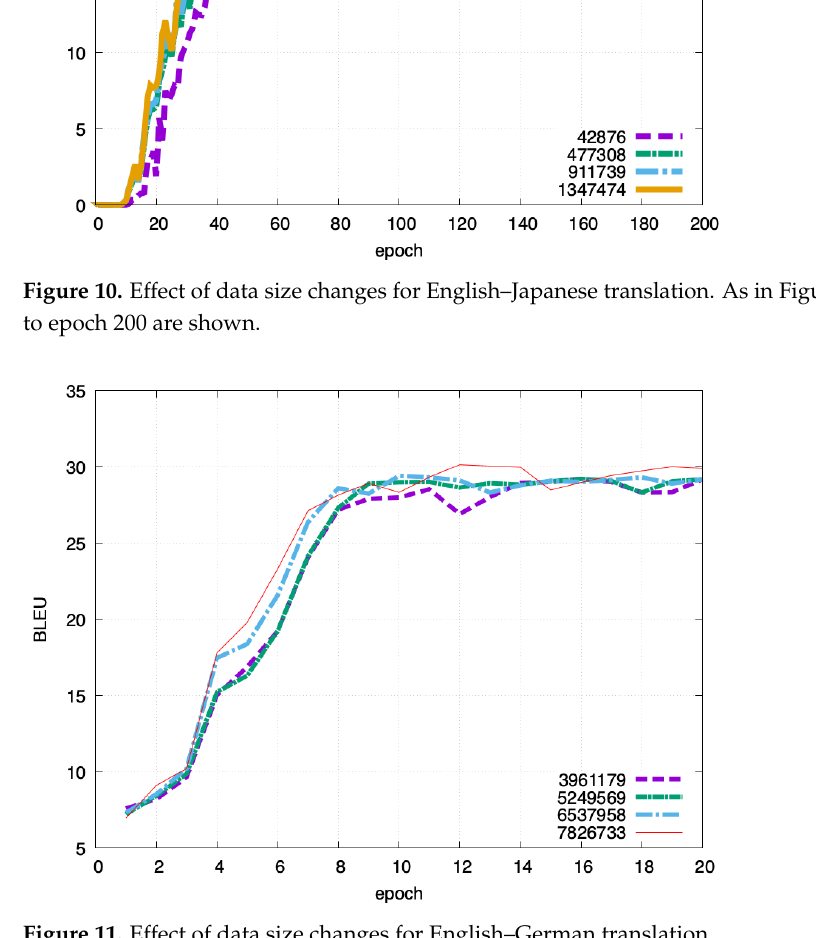
Figure 11. Effect of data size changes for English–German